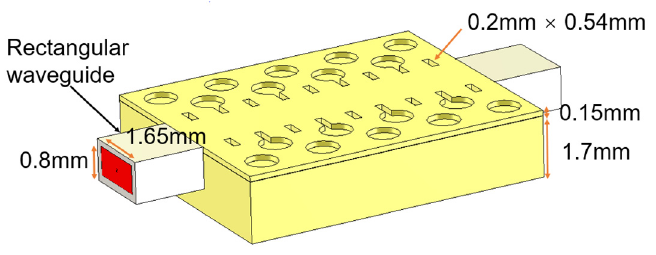
Figure 3. Dispersion diagram for the infinite periodic unit cell.